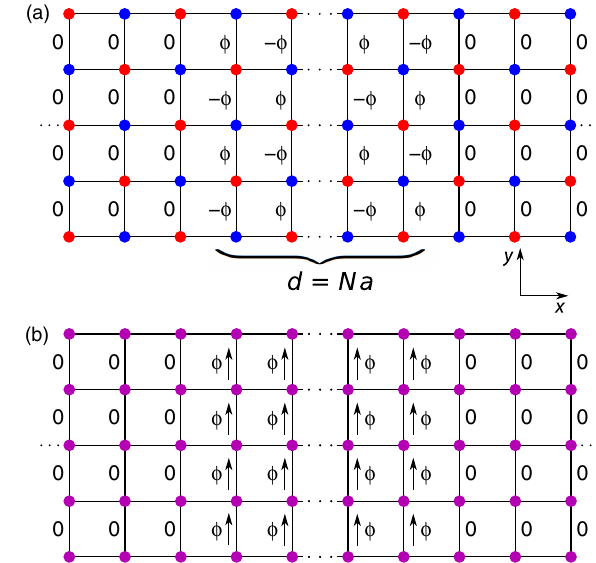
FIG. 4. (a) A square lattice of resonators with resonant frequencies ω (red) and ω (blue) described by the time- A B dependent Hamiltonian of Eq. (4). The label on each vertical bond denotes the phase of the dynamic modulation between nearest neighbors along the y direction. All the horizontal couplings have a zero modulation phase. (b) A square lattice of identical resonators with nearest-neighbor couplings described by Eq. (5), which is obtained after performing the rotating wave approximation on Eq. (4). In the core region, there is a direction- dependent coupling phase ( þ ϕ hopping upward and − ϕ hopping downward), which corresponds to a uniform gauge potential. Thus, under rotating wave approximation, the modulation phase in (a) is mapped into a time-independent gauge potential in